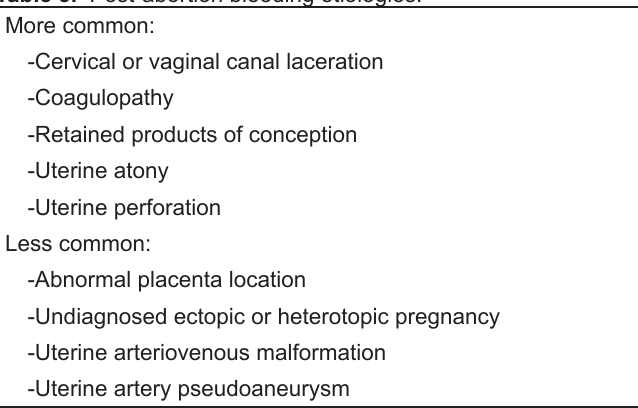
Table 3. Post-abortion bleeding etiologies. More common: